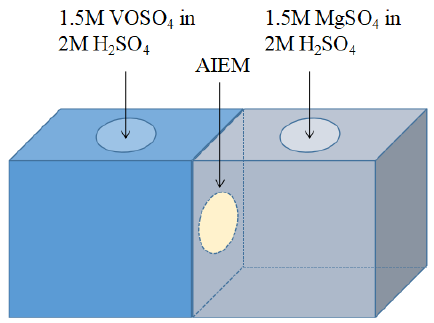
Figure 1. Illustration of the equipment for permeability of V (IV) ions test .